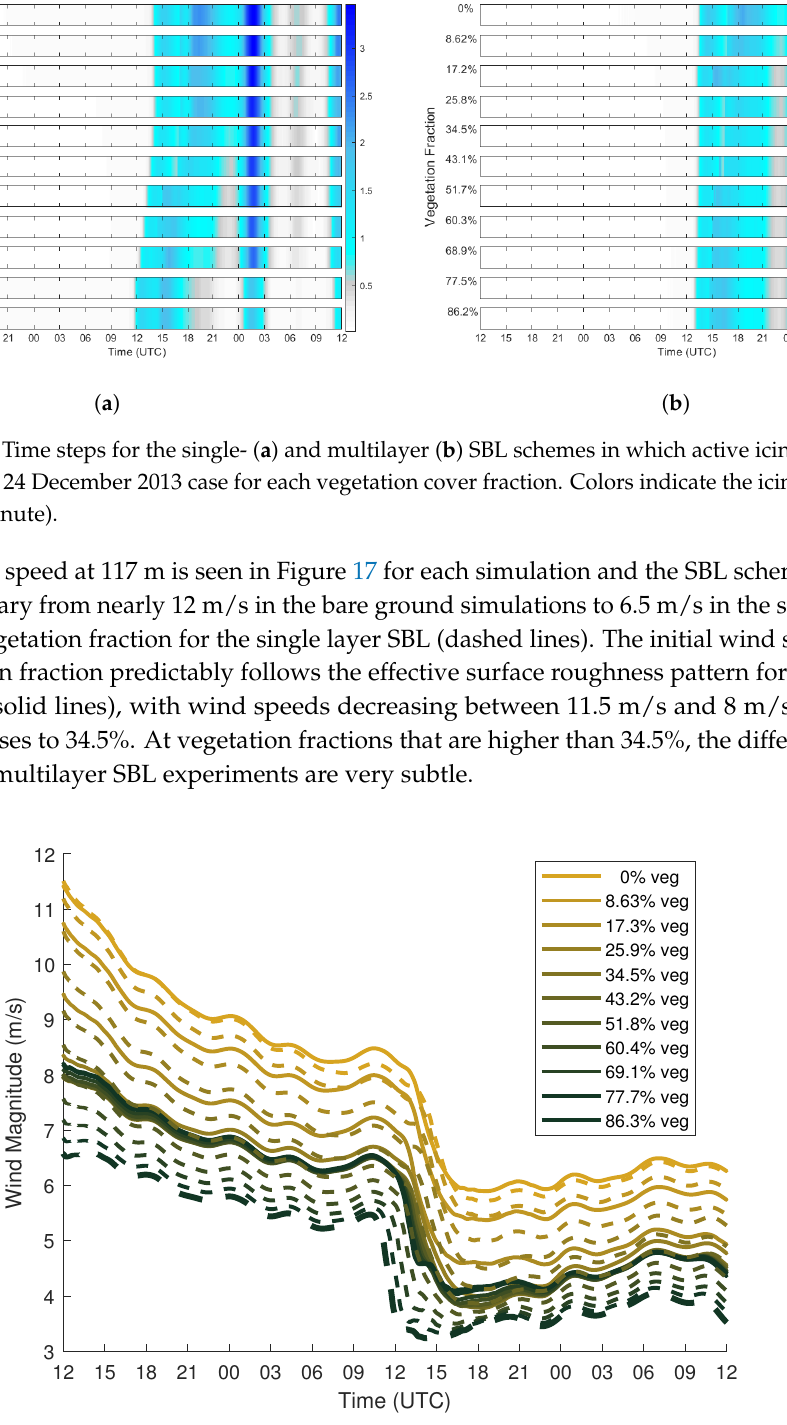
Figure 17. Time evolution of wind speed for the 24 December 2013 case at 117 m for each vegetation